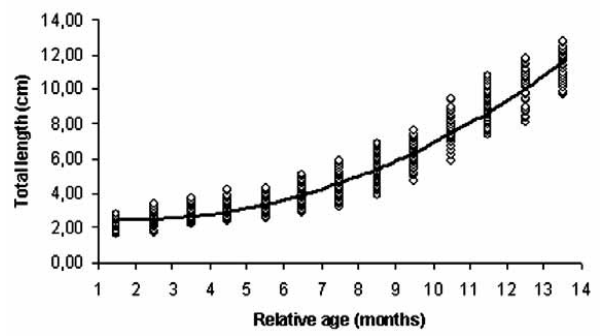
F IG . 2. – Parabolic growth curve of juvenile S. salpa from the Adriatic Sea (Lt = 0.069 t 2 – 0.198 t + 2.658; R 2 = 0.936)